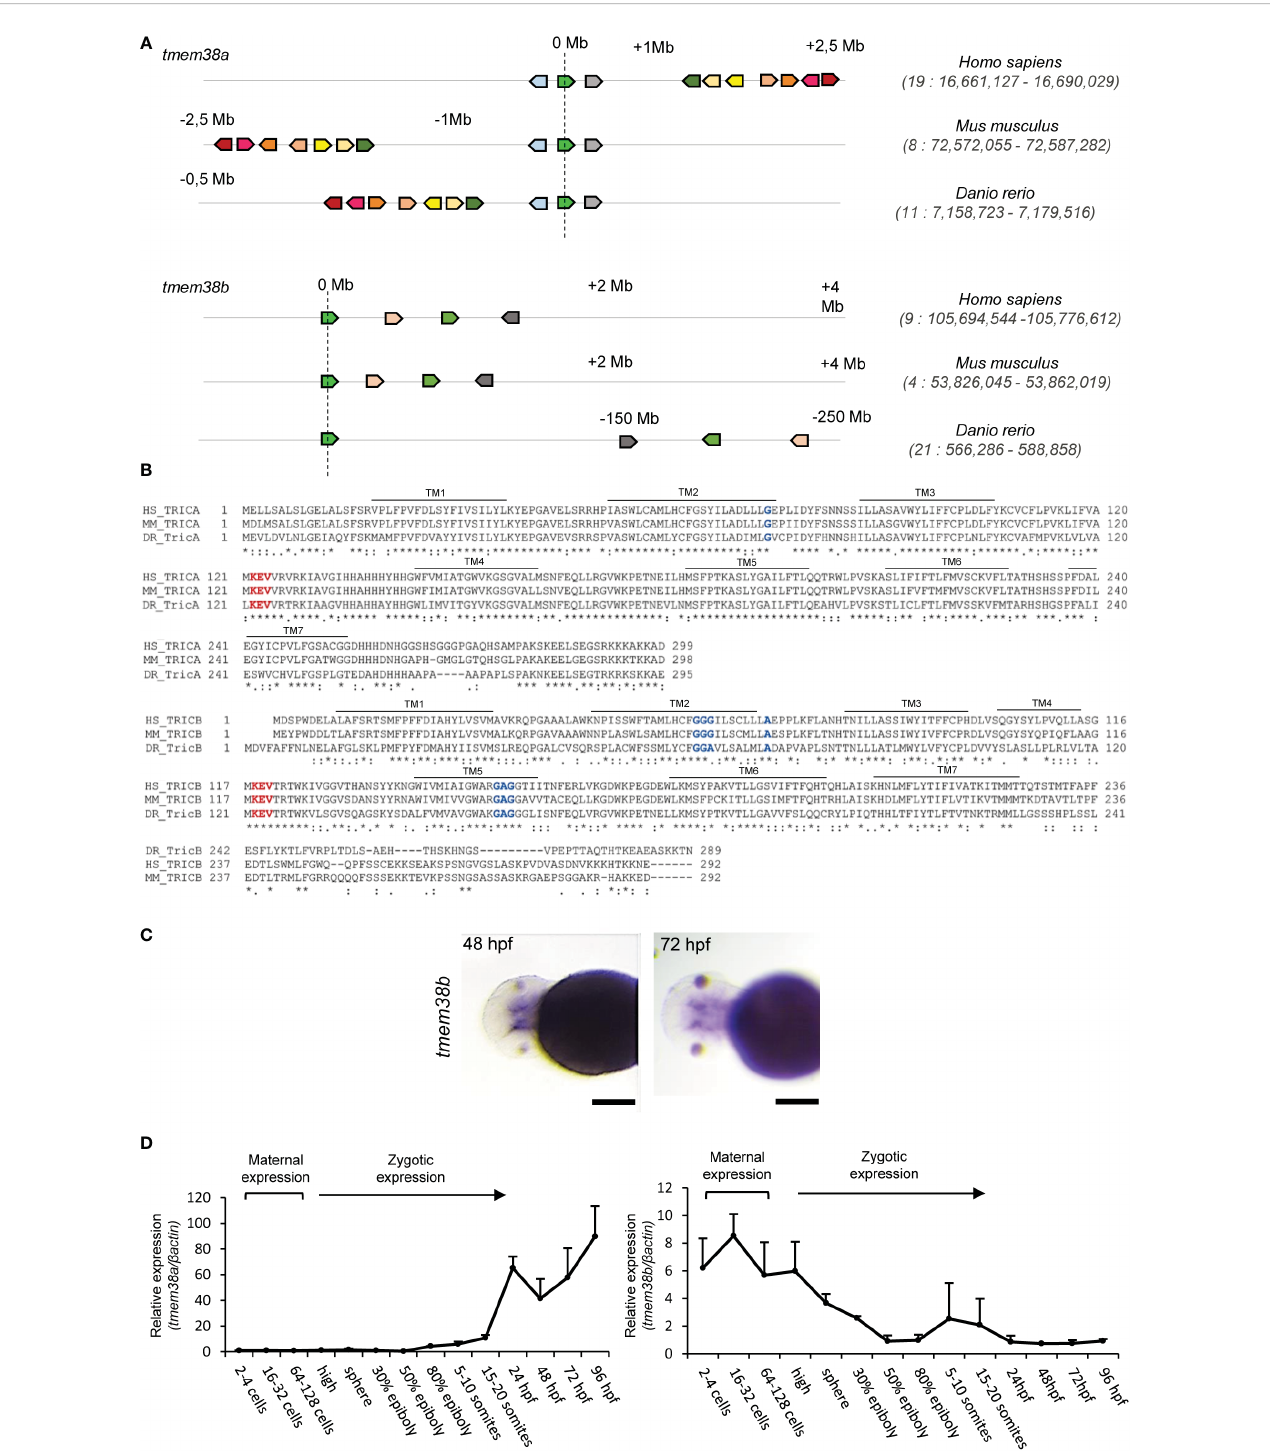
FIGURE 1 Analysis of tmem38a/b across species and of their spatio-temporal expression during zebra fi sh development. (A) The sinteny analysis performed on humans ( H. sapiens ), mice ( M. musculus ) and zebra fi sh ( D. rerio ) supported the existence of a common ancestral chromosomal origin for both t mem38a and tmem38b . The maps were obtained using the genome browser Genomicus. The human genes were used as roots. The position of the genes (Mb) relative to the investigated locus is based on Ensemble database and shown on top of the chromosome line. The exact chromosomal position of all the conserved genes is reported in the Supplementary Tables S1. The direction of the arrows indicates the gene orientation in respect to the reference gene. (B) Trimeric intracellular cation channel A (TRIC-A) and B (TRIC-B) domains are conserved among human, mouse and zebra fi sh. The 7 transmembrane domains (TM) are indicated. In red is shown the KEV pore channel domain, while in blue are indicated the two glycine reach regions in TM2 and TM5. (C) In situ hybridization analysis of 48 and 72 hpf WT embryos revealed the presence of tmem38b in the region of craniofacial cartilages. (D) Relative expression of tmem38a and tmem38b was evaluated by qPCR demonstrating a maternal expression only for tmem38b . The experiment was perfomed in duplicate. Scale bar:500 µm. Human TMEM38A ENSG00000072954, murine Tmem38a ENSMUSG00000031791, zebra fi sh tmem38a ENSDARG00000024047; human TMEM38B ENSG00000095209, murine Tmem38b ENSMUSG00000028420,zebra fi sh tmem38b ENSDARG00000100549. Tric-a:humanQ9H6F2, murine Q3PMT8, zebra fi shQ6P2T0;Tric-b:humanQ9NVV0,murineQ9DAV9, zebra fi